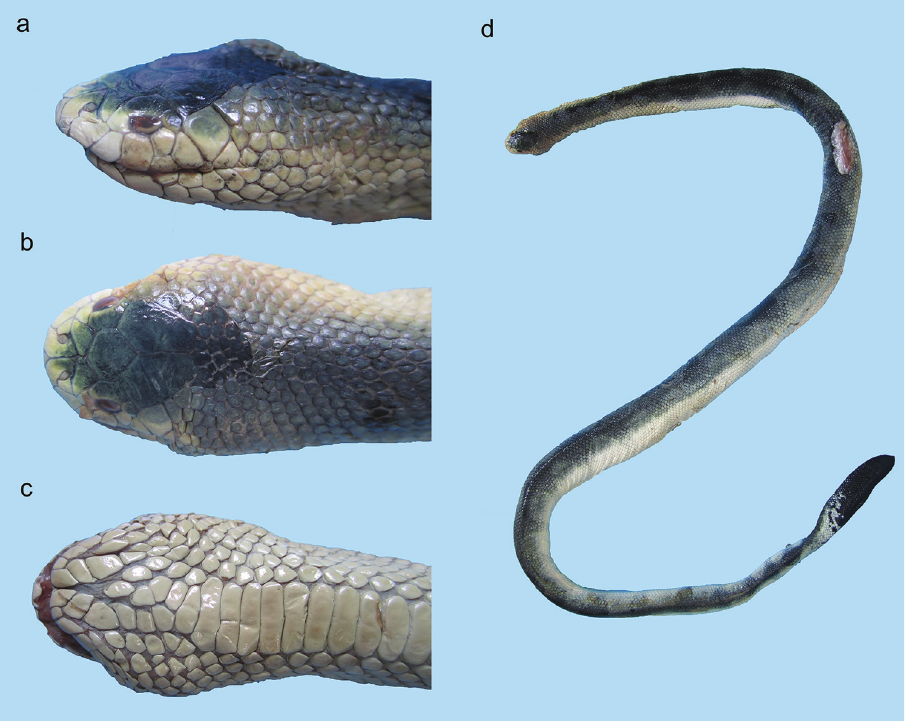
Figure 9. Hydrophis viperinus : a lateral view b dorsal view, and c ventral view of head d